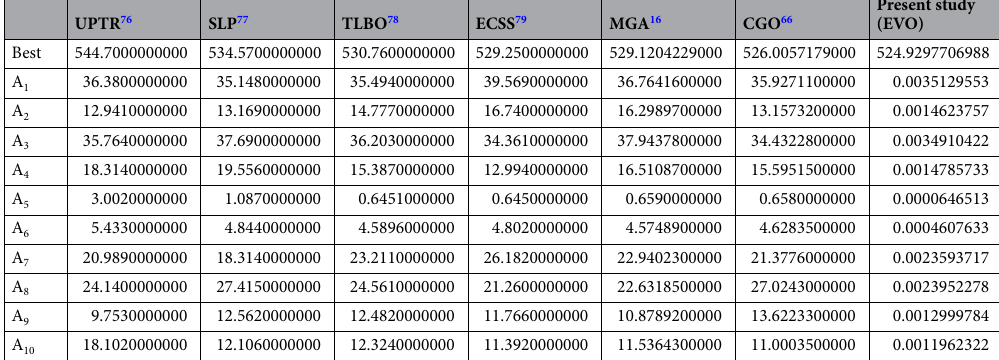
Table 12. Comparison of the best solutions for the ten-bar truss design problem. cross-sectional areas of the truss bars (A1, A2, A3, A4, A5, A6, A7, A8, A9,A10). IPTR, Interior Point Trust Regio; SLP, Sequential Linear Programming; ECSS, Enhanced Charged System Search.